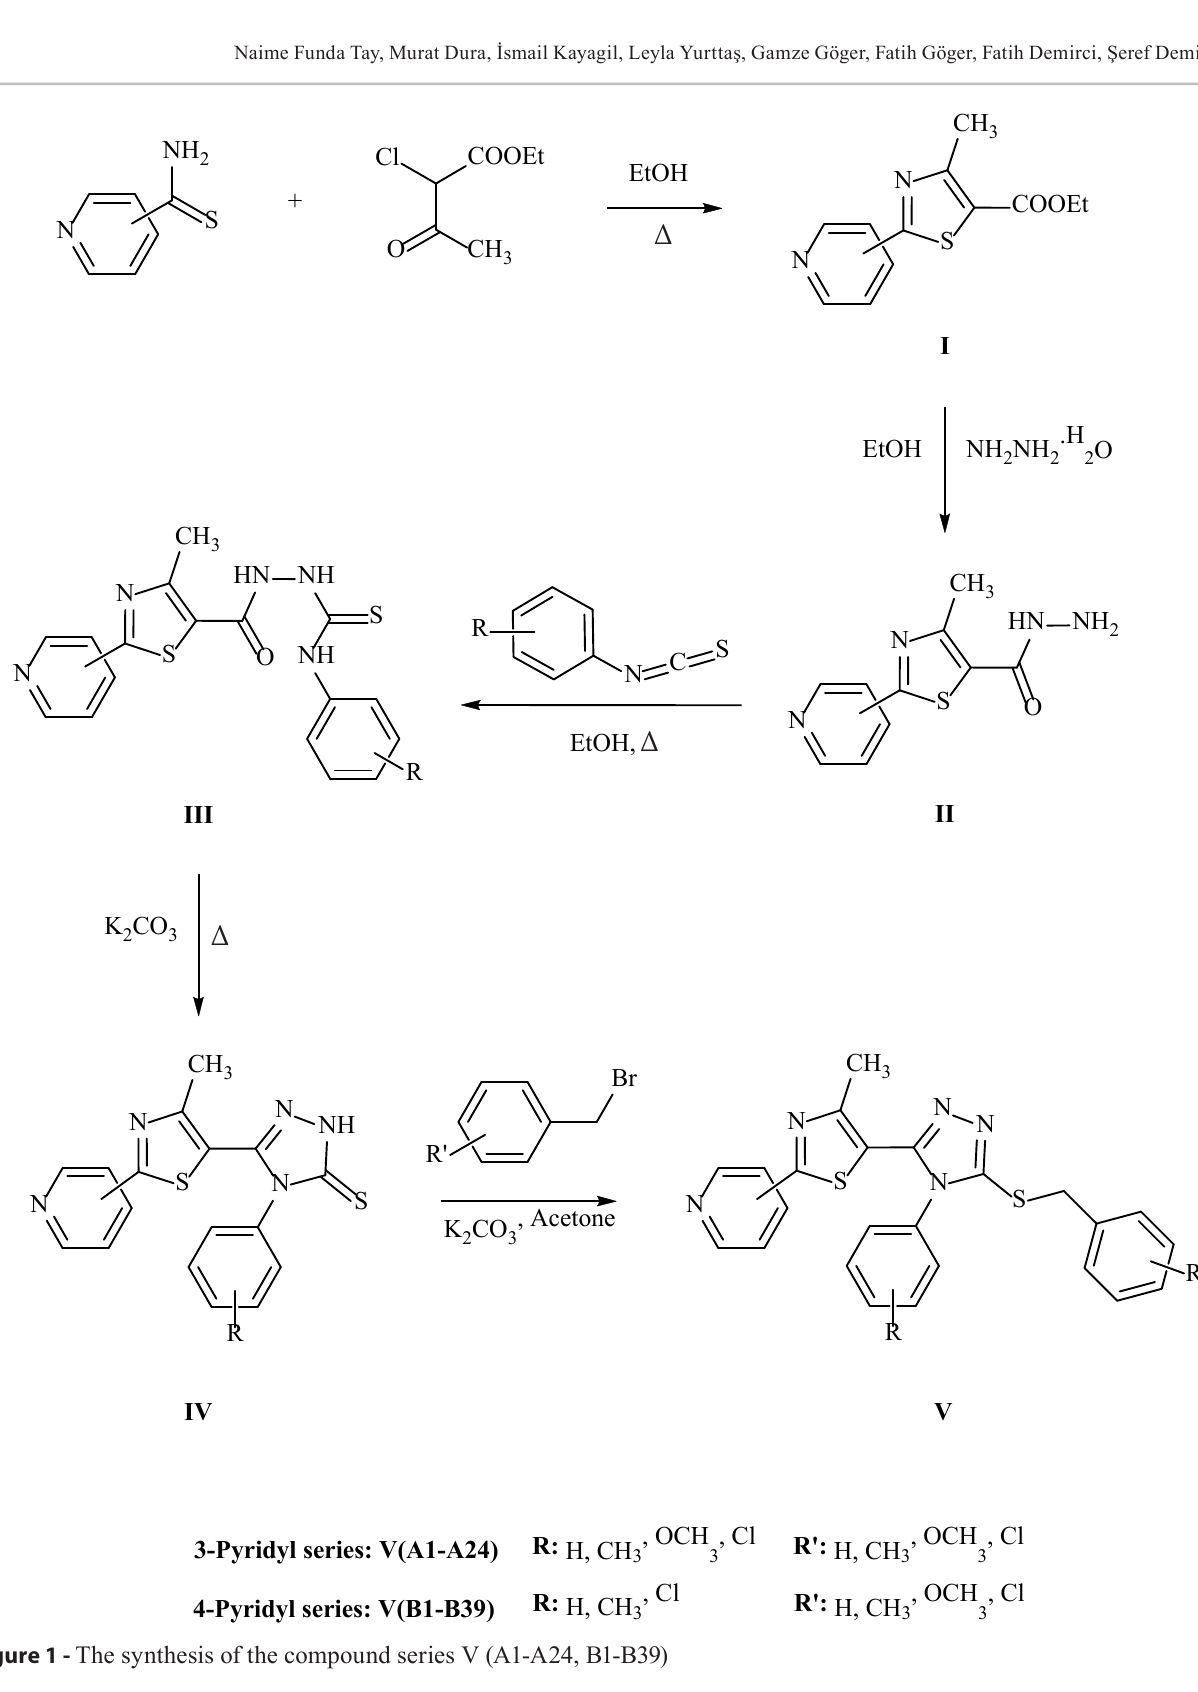
Figure 1 - The synthesis of the compound series V (A1-A24,